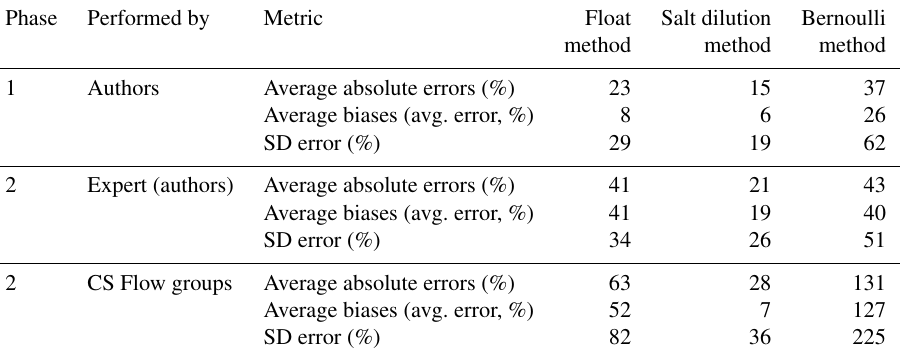
Table 6. Summary of average absolute errors, average biases, and error standard deviations (SD error) for phase 1 and 2 measurements. All values are shown as percentages rounded to the nearest integer. Phase Performed